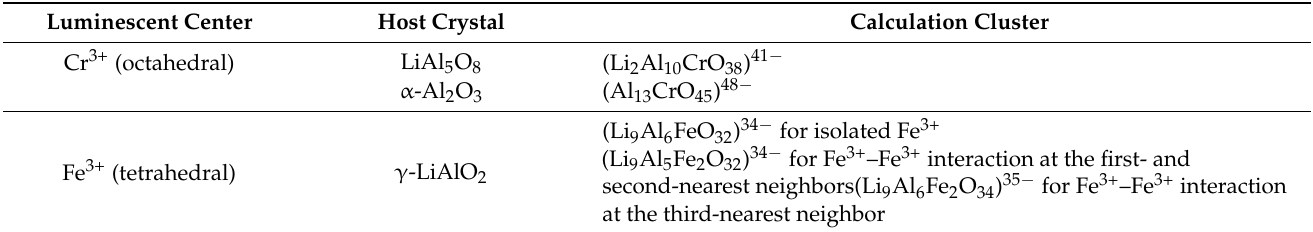
Table 2. Clusters for molecular orbital calculations.